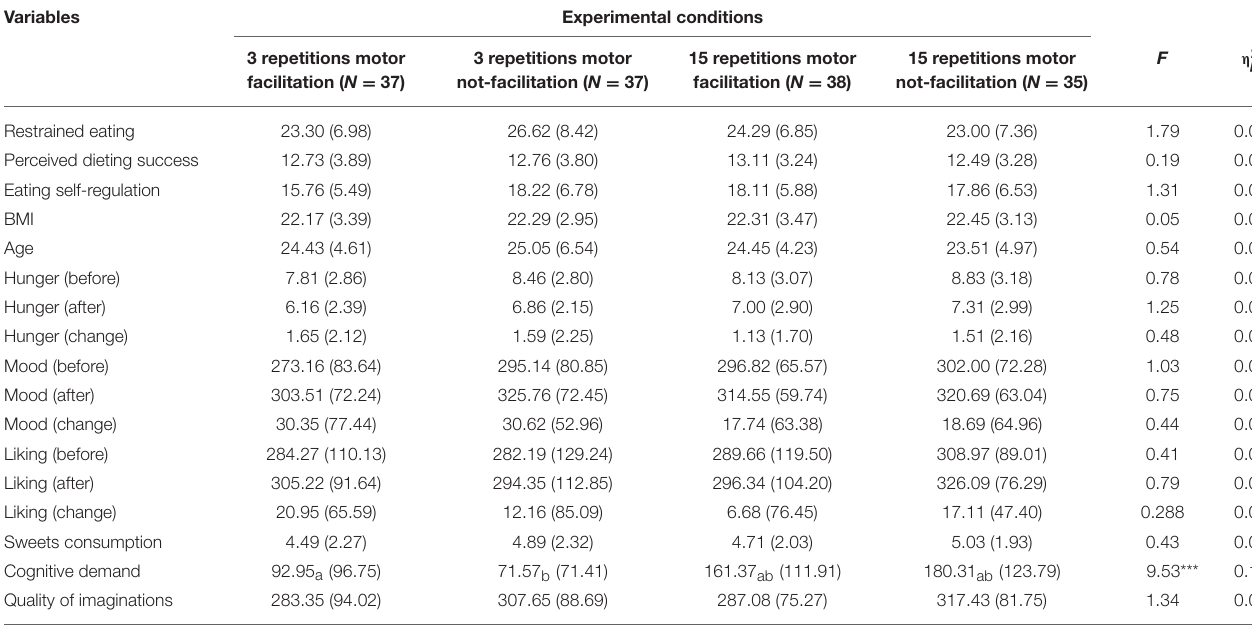
TABLE 1 | Descriptive (means and standard deviations) statistics of variables as a function of the experimental conditions and inferential statistics for group comparisons. Variables Experimental conditions